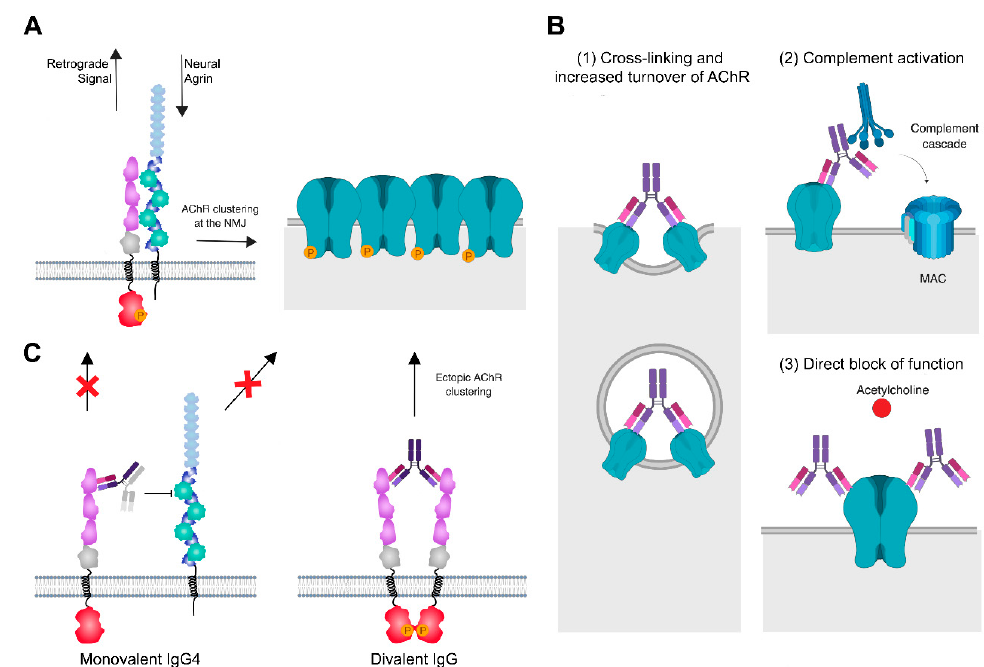
Figure 3. Pathogenic mechanisms of MG autoantibodies at the NMJ. ( A ) At the healthy NMJ, neural Agrin stimulation induces interaction between Lrp4 and MuSK, leading to MuSK autophosphorylation and activation and the phosphorylation and clustering of AChRs. A retrograde signal for presynaptic development is sent via Lrp4. ( B ) MG antibodies of IgG1 and IgG3 subclass against AChR have three pathogenic mechanisms: (1) Cross-linking and increased turnover of AChR lead to reduced AChR levels at the NMJ, (2) activation of the classical complement cascade, formation of the membrane attack complex (MAC) and complement-mediated damage of the postsynaptic membrane, and (3) direct block of function by preventing the binding of acetylcholine. ( C ) Bispecific IgG4 antibodies of IgG4 subclass against MuSK bind monovalently to MuSK and block Lrp4-MuSK interaction, thus interrupting the agrin-Lrp4-MuSK-Dok7 signaling axis and causing reduced densities of AChR at the synapse. A further e ff ect is the disruption of a retrograde signal from Lrp4 to the motor neuron. Divalent binding of MuSK IgG leads to dimerization, autophosphorylation, and activation of MuSK independent of Agrin stimulation and causes the formation of ectopic AChR clusters. Created with BioRender.